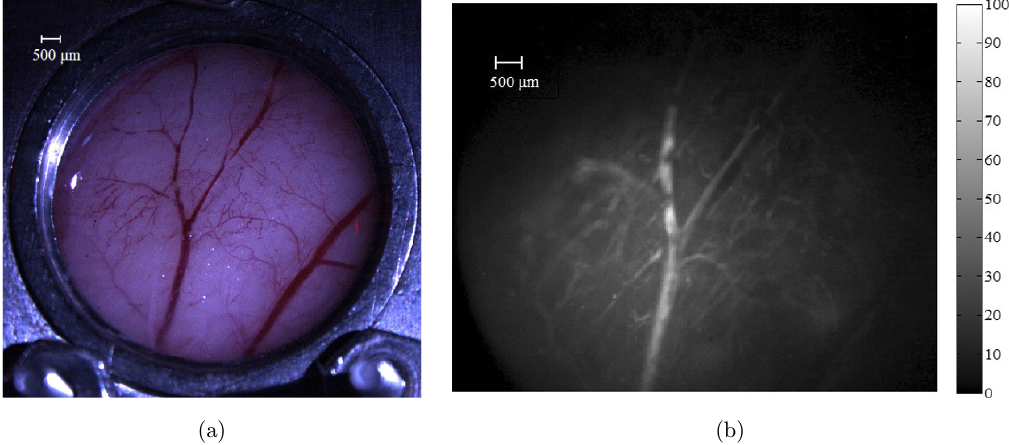
Fig. 6. (a) White-light and (b) 1 O 2 luminescence images for the blood vessels within a rodent dorsal window chamber